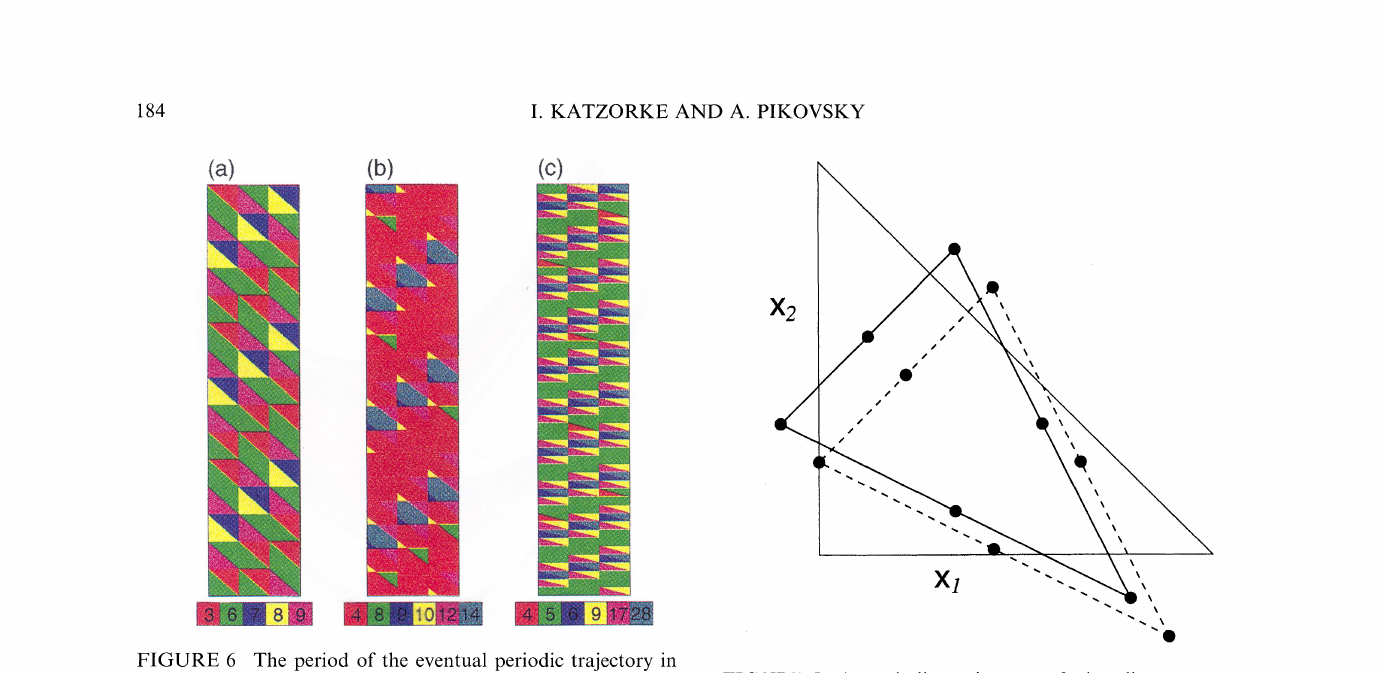
FIGURE 7 A periodic trajectory of the discrete system, shown in Xl-X2 coordinates (solid line). The dots mark the integer moments of time. The trajectory can be shifted unless the dots do not cross the borders of the triangle; one possible position is shown with the dashed